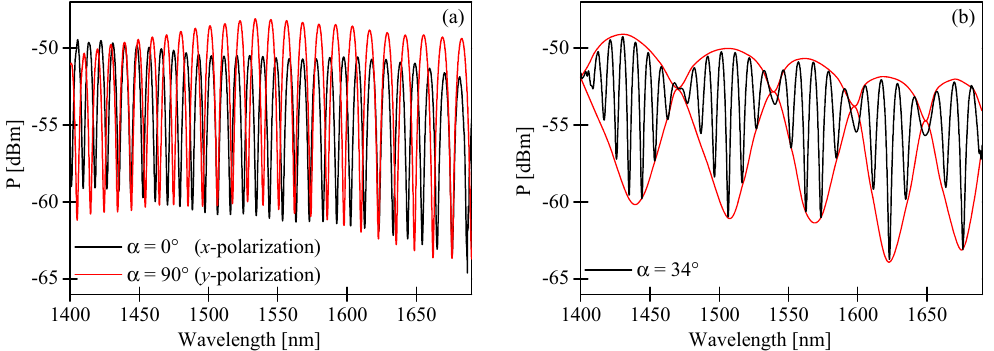
Figure 3. Spectral interference fringes at the output of an in-line intermodal interferometer based on a 56-mm long two-mode HB MOF for excited x -polarization (black line) and y -polarization (red line) ( a ) and both polarization modes by setting the azimuth of the input polarization state at α = 34° ( b ).